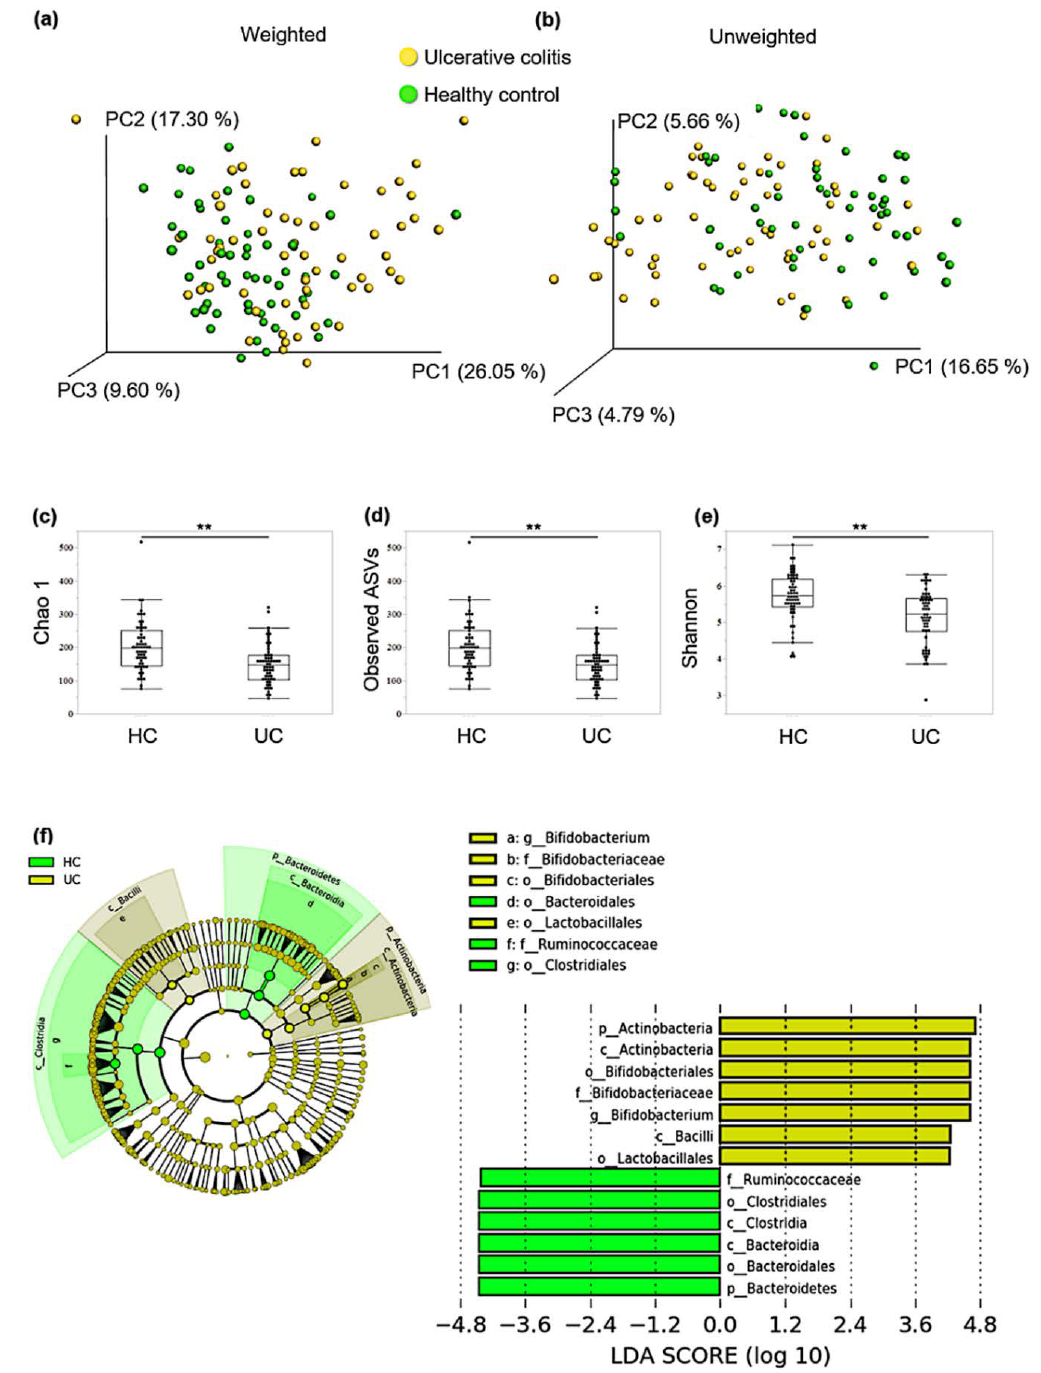
Figure 1. Comparison of the structure of gut microbiota between healthy controls (HCs) and patients with ulcerative colitis (UC). Principal coordinate analysis (PCoA) plots of gut microbiota based on ( a ) weighted and ( b ) unweighted UniFrac distances as β -diversity was calculated (PERMANOVA, p < 0.01). Yellow dots indicate patients with UC and green dots indicate HCs; As for α -diversity, ( c ) Chao 1 (ASV richness estimation); ( d ) observed ASVs; ( e ) Shannon (ASV evenness estimation) indices were significantly lower in patients with UC than those in HCs; ( f ) linear discriminant analysis effect size (LEfSe) analysis identified taxa that characterized each group. Cladogram of LEfSe analysis results. Yellow-shaded areas indicate taxa that characterize UC, and green-shaded areas indicate taxa that characterize HCs. Linear discriminant analysis (LDA) scores for identified taxa of patient of UCs (7 taxa) and HC (6 taxa) was shown. ** p <